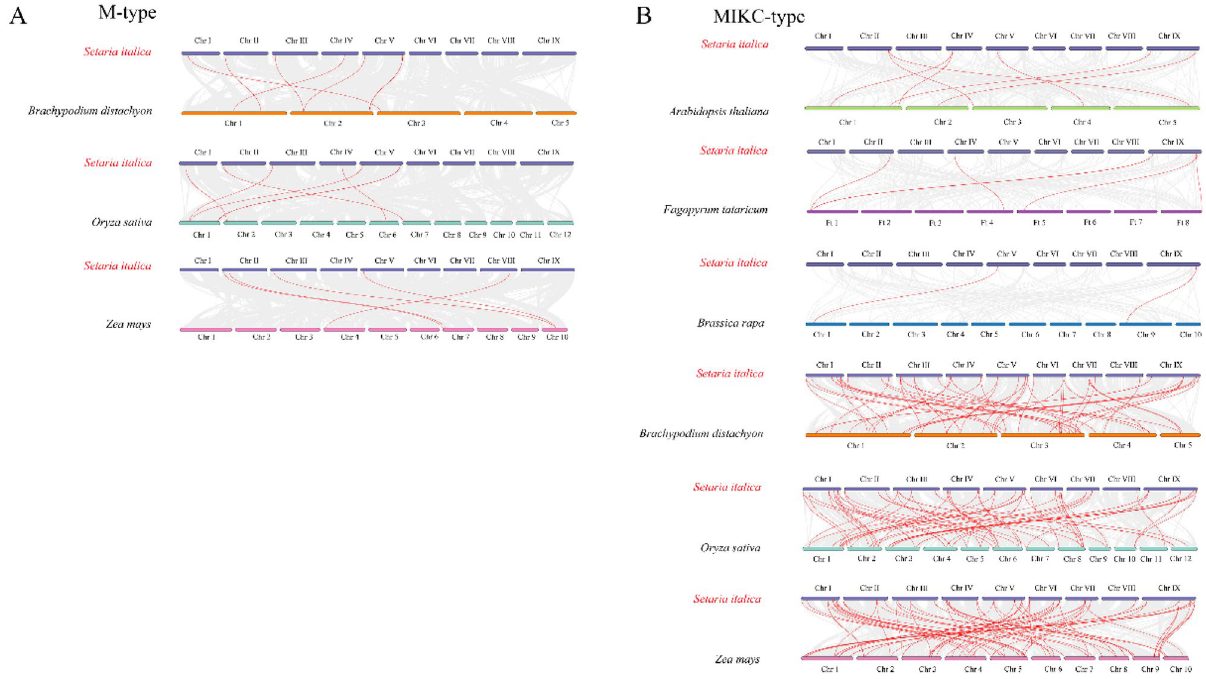
Figure 5. Synteny analysis of MADS-box genes between S. italica and other plant species. ( A ) Synteny analysis of the M-type MADS-box genes between S. italica and three representative plant species ( B. distachyon , Oryza sativa , Zea mays ). ( B ) Synteny analysis of the MIKC-type MADS-box genes between S. italica and six representative plant species ( A. thaliana , F. tataricum , B. rapa , B. distachyon , O. sativa , Z. mays ). Gray lines in the background indicate the collinear blocks within S. italica and other plant genomes, while red lines highlight the syntenic MADS gene